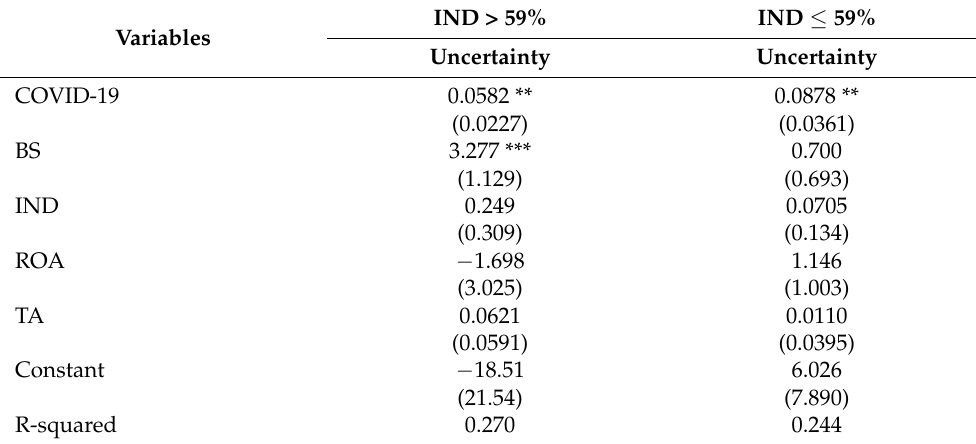
Table 6. Regression for IND > the mean vs. IND ≤ the